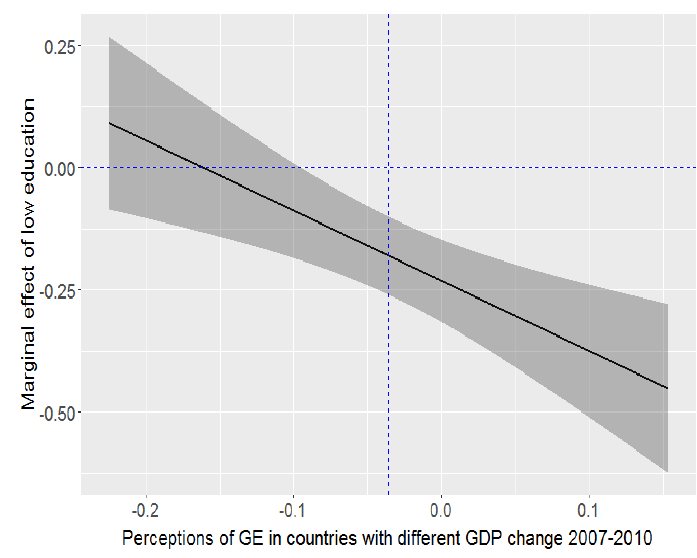
Figure 3 . Effect of low education upon GA in countries with different GDP